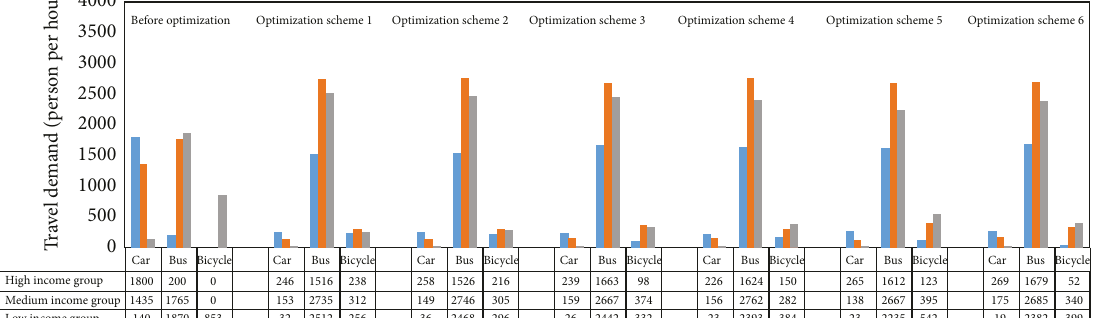
Figure 5: Compared the different traffic mode ridership.